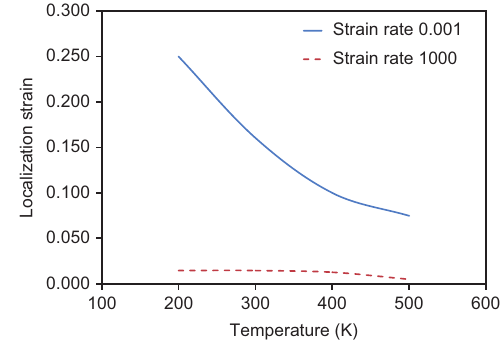
Figure 19 Occurrence of localization strain vs. temperature for CR-1018